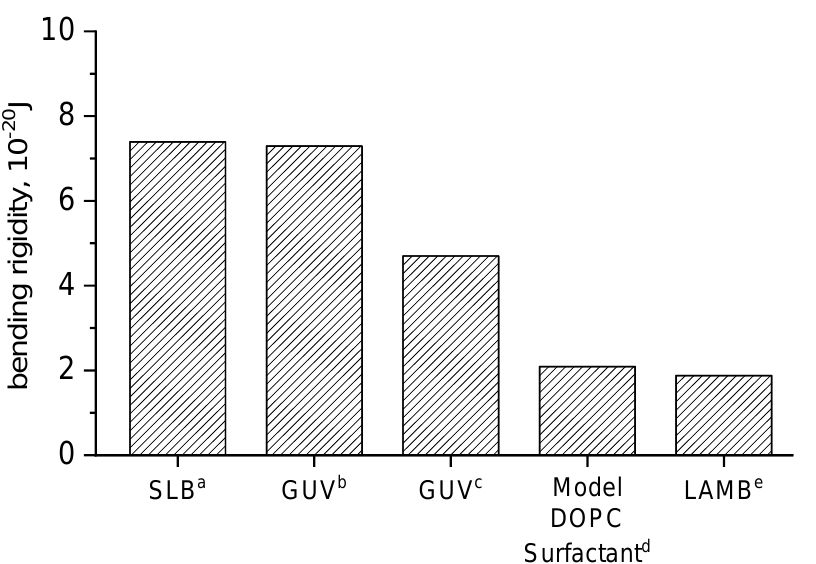
Figure 3. Comparison of bending rigidities of DOPC bilayers studied in different platforms: (a) ref [34], (b) ref [12], (c) ref [35], (d) ref [33], and (e) LAMB (this work).